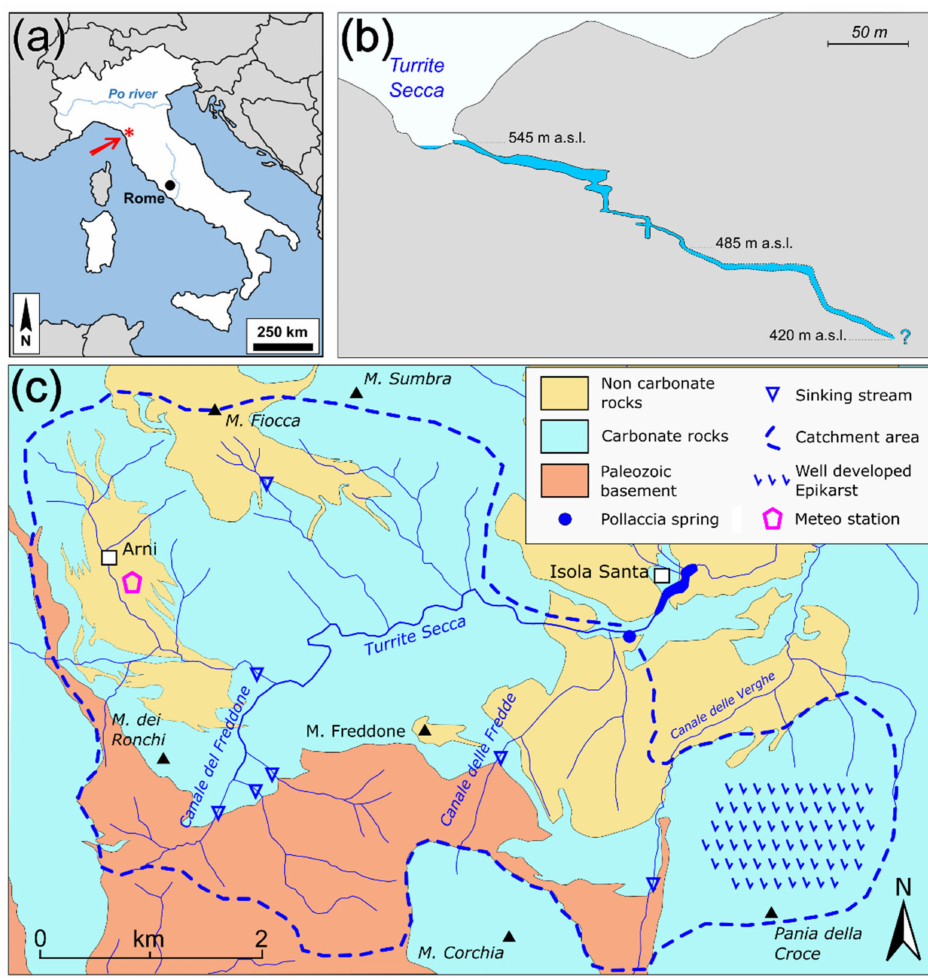
Figure 2. ( a ) Location map; the red arrow indicates the study area; ( b ) cross-section of the deep phreatic tube explored by divers down to − 120 m; ( c ) hydrogeological map of the catchment area feeding the Pollaccia